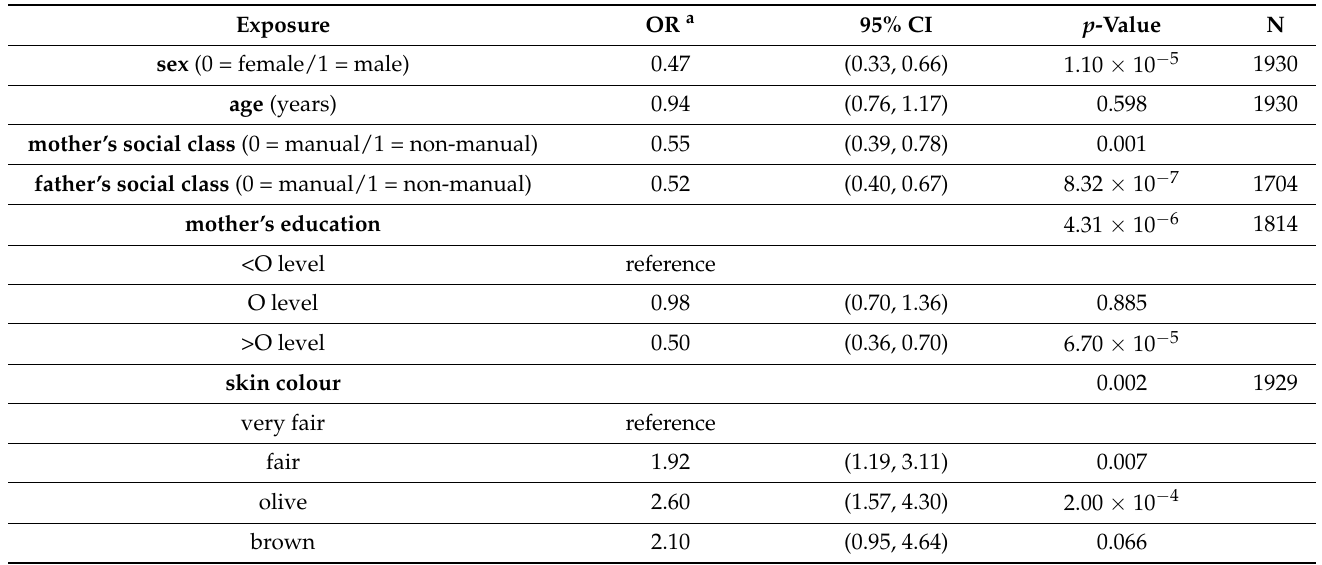
Table 3. Association of socio-demographic, pigmentation-related, and sun exposure factors with usually tanning indoors using a sun bed/sun lamp/tanning booth amongst ALSPAC young people (YP) who like to